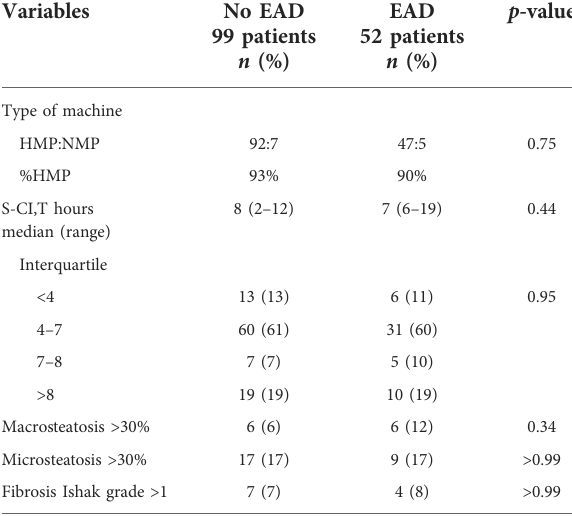
TABLE 7 Univariate analysis of graft histology features, type of machine perfusion used, and S-CIT for EAD. Variables